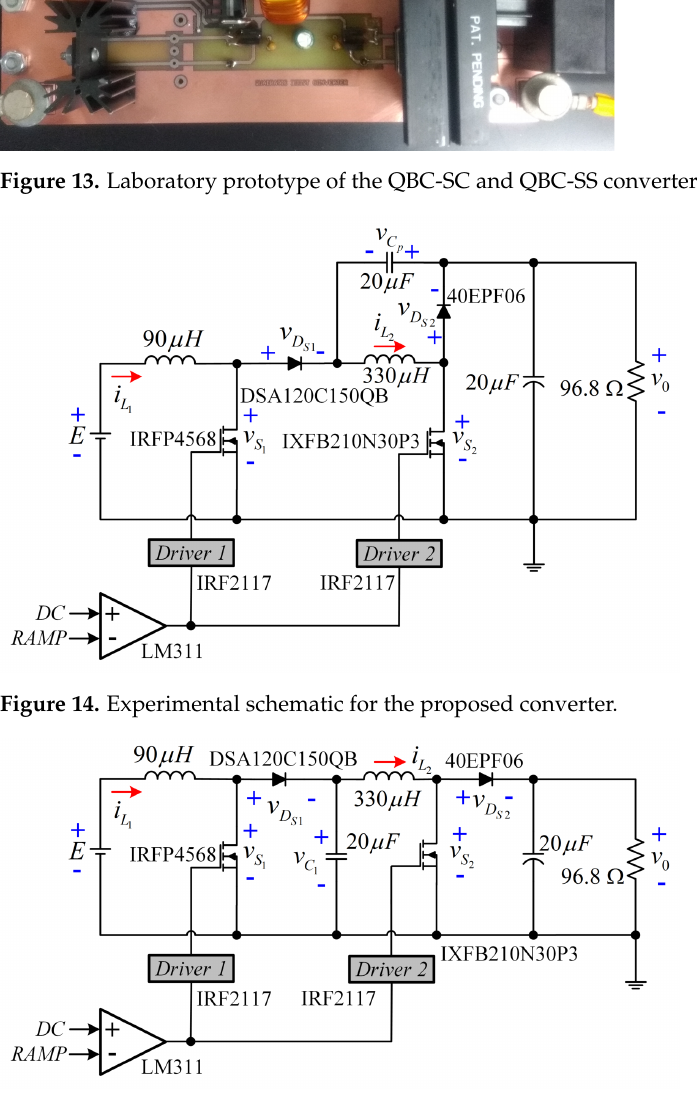
Figure 15. Circuit of the QBC-SC prototype for the experimental efficiency comparison with the proposed